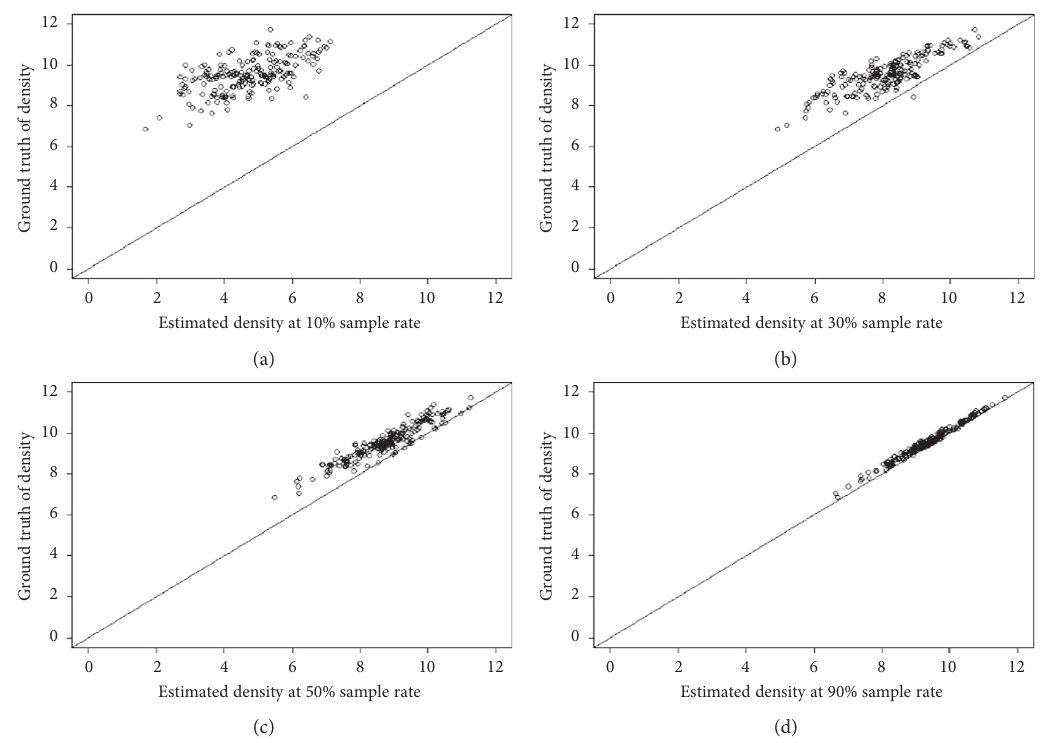
Figure 11: Scatter plot by sample rate of scenario 2 (empirical evaluation) (a) Scatter plot at 10% sample rate. (b) Scatter plot at 30% sample rate. (c) Scatter plot at 50% sample rate. (d) Scatter plot at 90% sample rate. Table 9: MAPE by sample rate, unit section and unit time of scenario 1 (empirical evaluation). Sample rate (%)